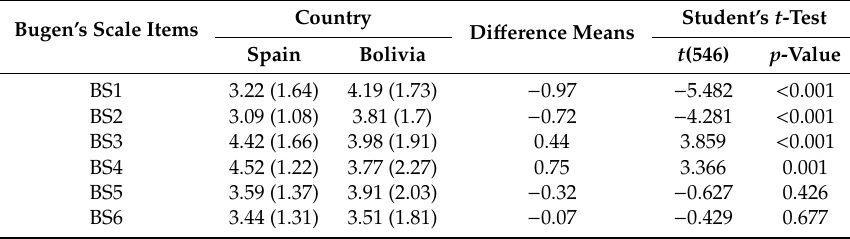
Table 4. Descriptive and comparative analysis of items on the Bugen’s scale by country. Bugen’s Scale